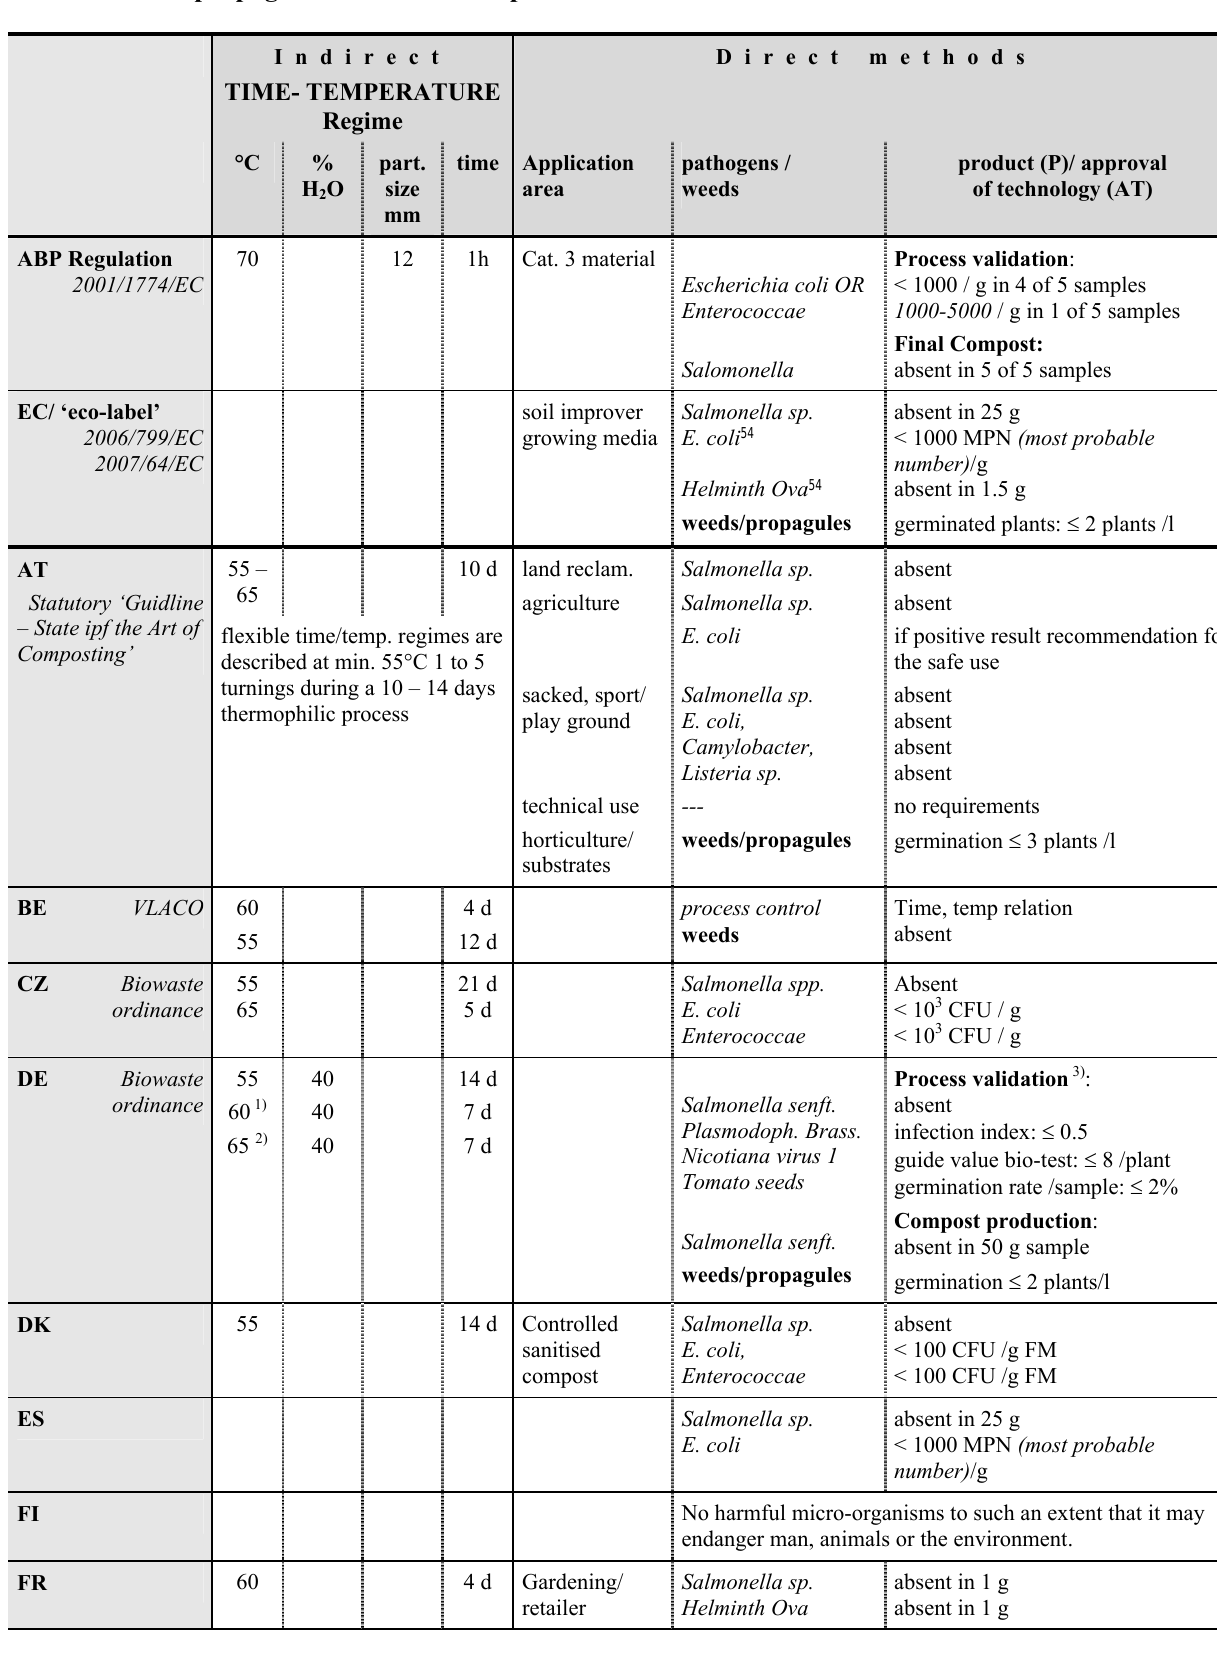
Table 22 Provisions for the exclusion of pathogens and germinating weeds and plant propagules in several European